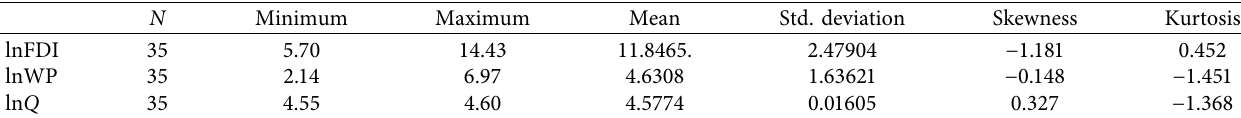
Table 2: Descriptive statistics variables.